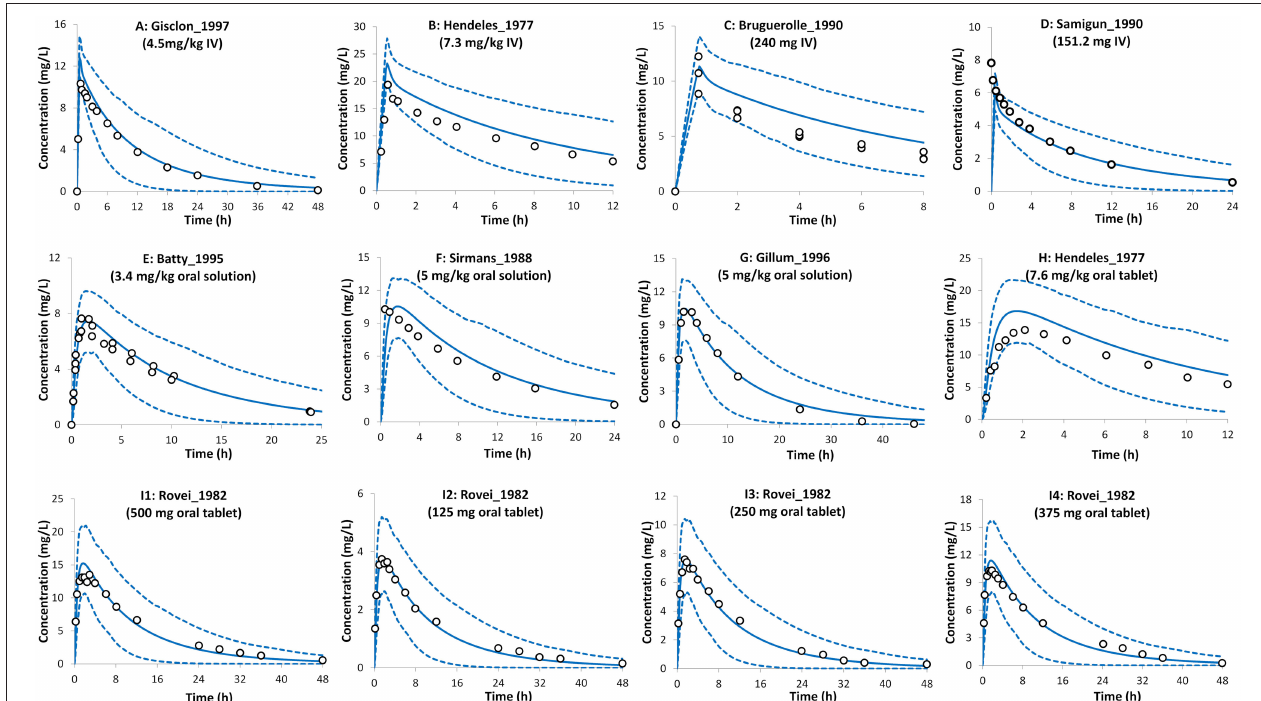
FIGURE 2 | Plasma concentration profiles after intravenous infusion and oral administration in the non-pregnant population. Solid lines, predicted means; Dashed lines, 5th and 95th centiles; Circles, observed means. (A) Trial design NP1 ( 24), (B) Trial design NP2 (19), (C) Trial design NP3 (29), (D) Trial design NP4 (30), (E) Trial design NP5 (31), (F) Trial design NP6 (32), (G) Trial design NP7 (33), (H) Trial design NP8 (19), and (I1–I4) Trial design NP9 (34). See the Method section for trial